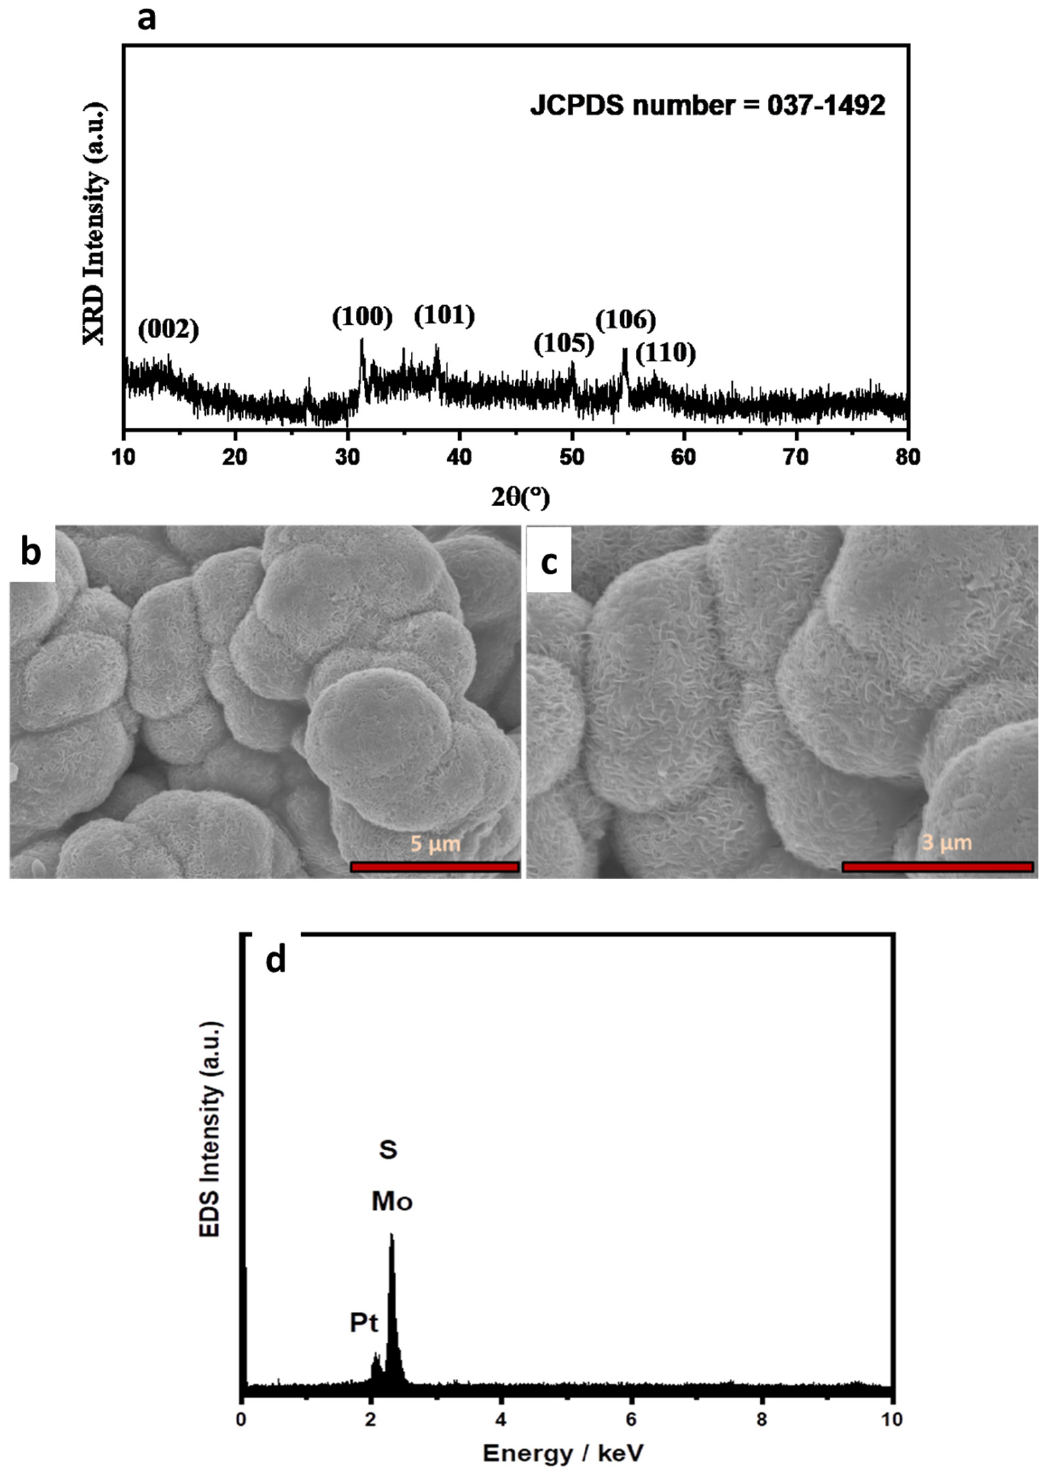
Figure 1. ( a ) PXRD and SEM images ( b , c ) and EDX spectrum ( d ) of the prepared MoS 2 .